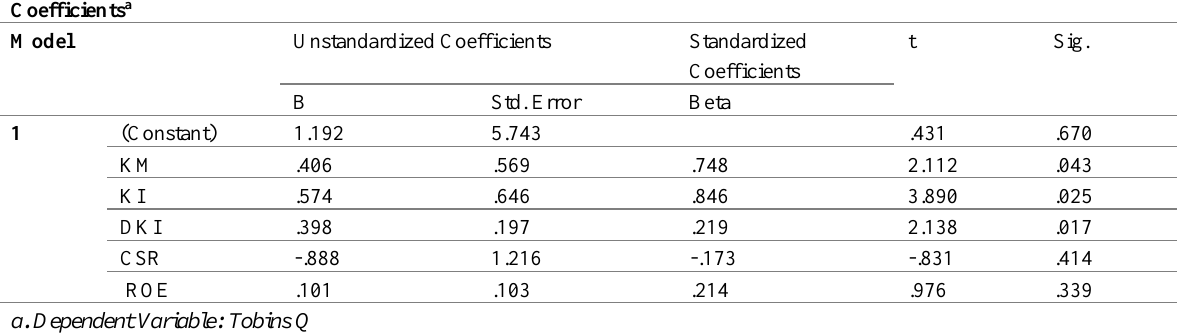
Table 3: Multiple Linear Regression Test Results Coefficients